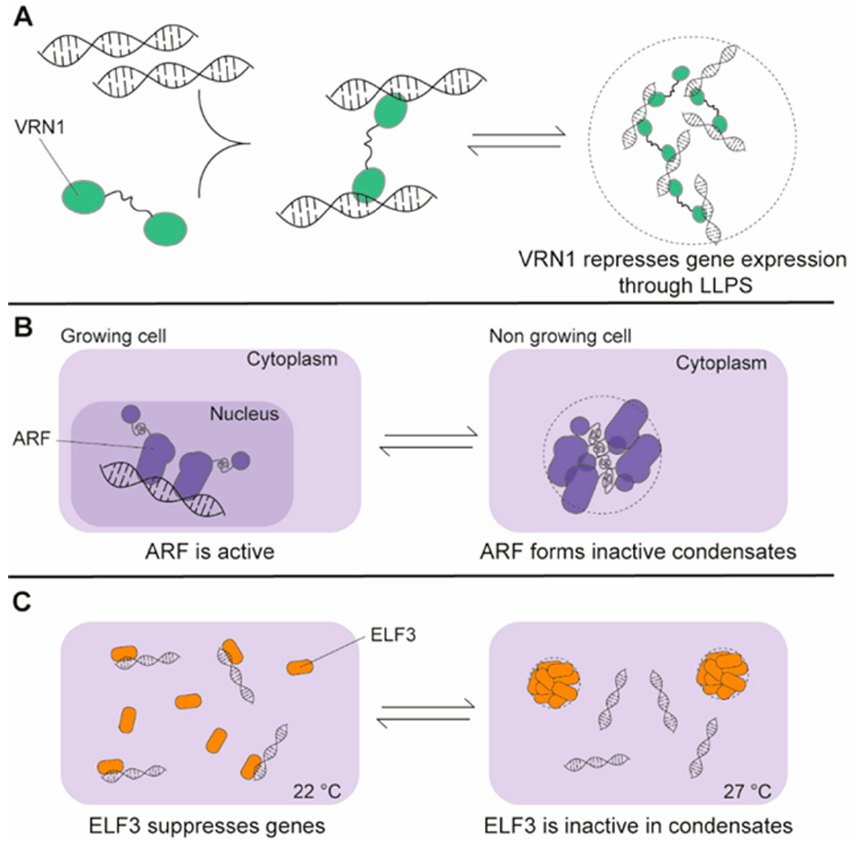
Figure 4. Phase separation in transcriptional regulation in plants. ( A ) The TF VRN1 undergoes phase separation in the presence of DNA to form organelles repressing gene expression. ( B ) ARF TFs promote cellular growth and differentiation through DNA-binding in the nucleus. In the stationary phase cells, the TFs are inactive in cytoplasmic condensates. ( C ) ELF3 regulation is temperature dependent: at 22 °C the protein is free and binds DNA to repress transcription, at 27 °C it undergoes protein-protein demixing to promote the genes expression.